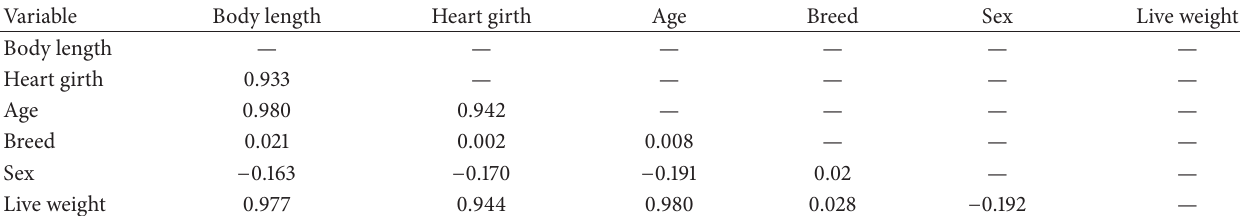
Table 1: Pearson’s correlation coefficient between live weight and the independent variables ( 𝑛 = 202